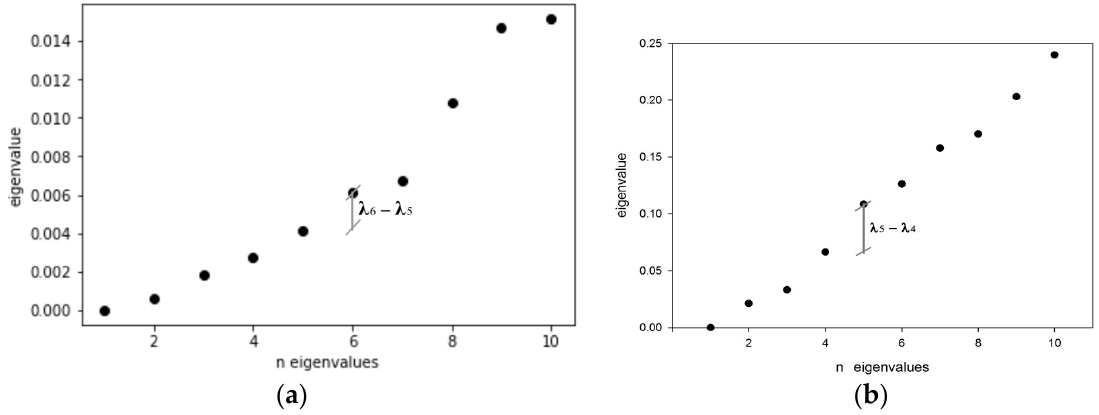
Figure 6. First 10 eigenvalues for the two case studies: ( a ) C-Town network; and, ( b ) Parete network.